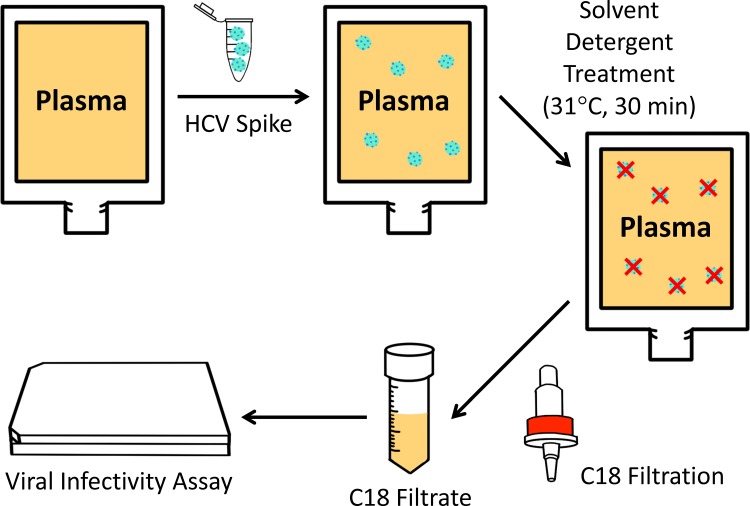
Flowchart of SD treatment and C18 filtration procedure on human plasma for HCV infectivity assay.